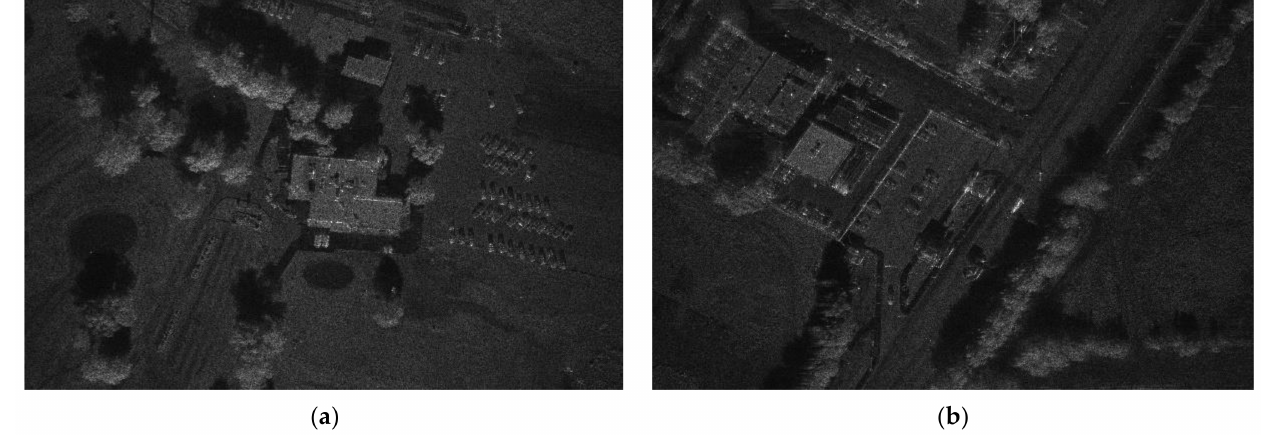
Figure 2. Two images of miniSAR dataset: ( a ) image A. ( b ) image B.